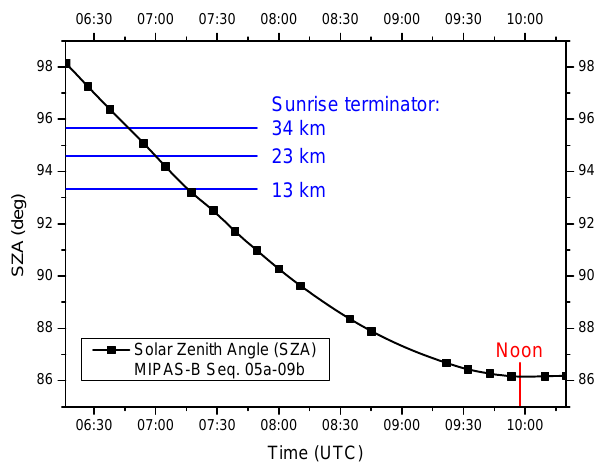
Fig. 2. Variation of the solar zenith angle (SZA) for MIPAS-B measured limb sequences 05a–09b (24 January 2010). Each black square denotes one recorded limb sequence. Altitude dependent local sunrise is given by the intersection of the black SZA line with the corresponding blue horizontal lines. Local noon is marked by a red line.